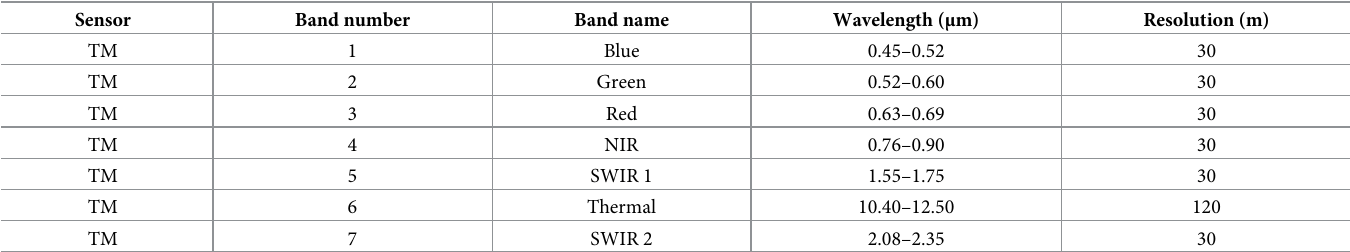
Table 1. Characteristics of Landsat 5 TM bands.